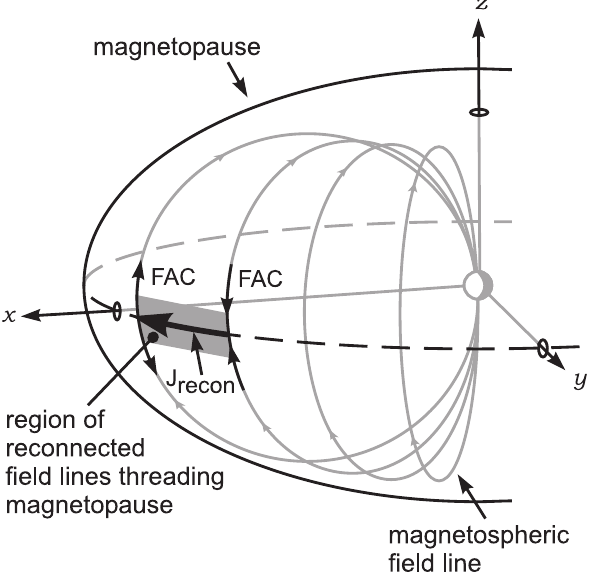
Fig. 9. The dayside current wedge. The westward current induced in the merging region flows along the geomagnetic field lines down to the ionosphere then eastward in the ionosphere parallel to the electric field as the Pedersen current nears the equatorward bound- ary of the ionospheric cusp signature, and back out to the magneto- sphere along the geomagnetic